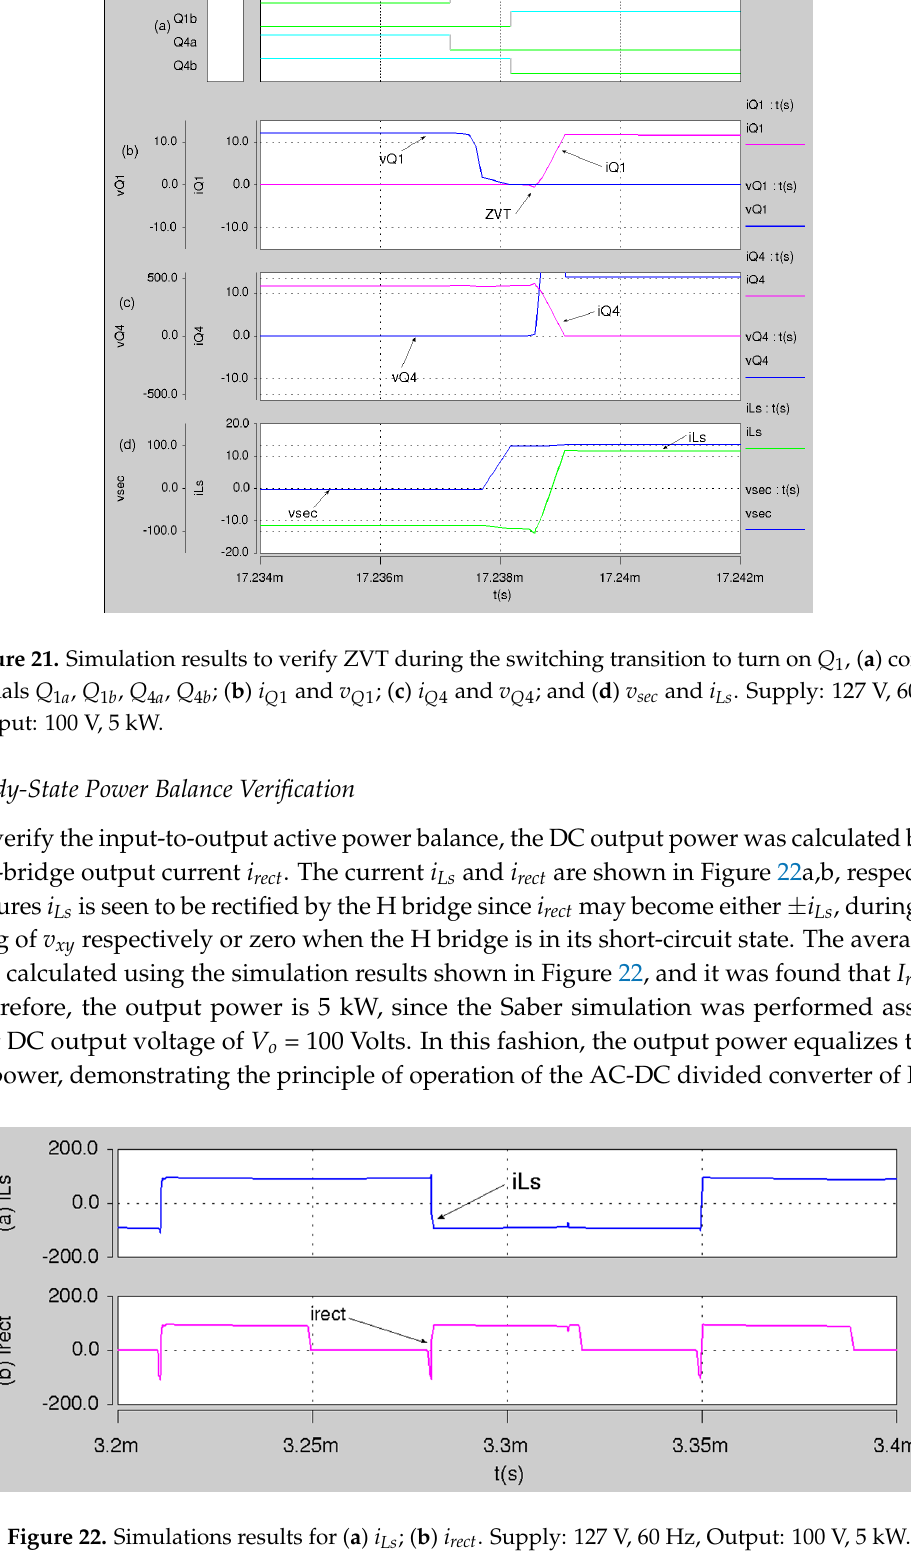
Figure 23. Harmonic content for line current i a .